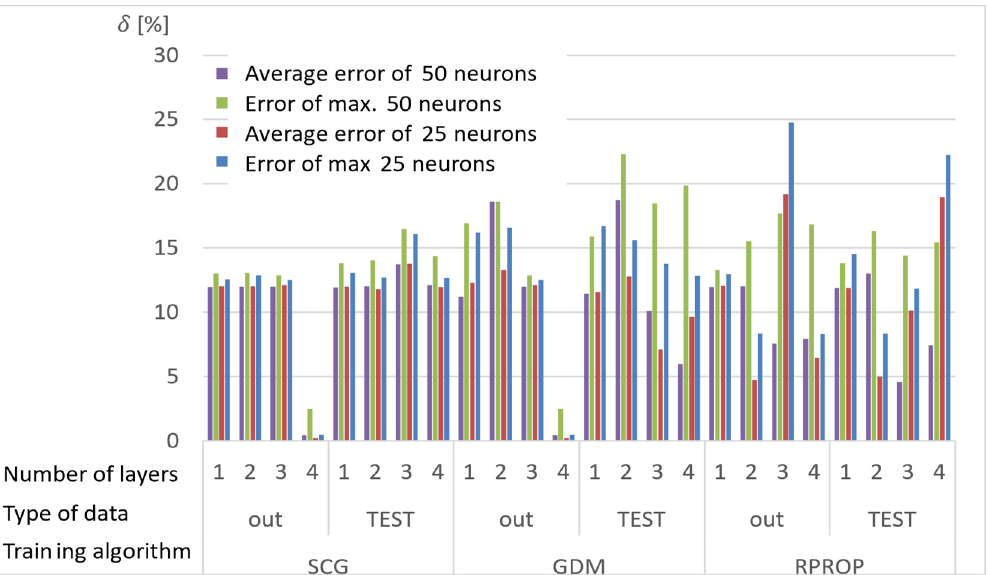
Figure 9. Maximum and average relative error for selected structures of neural networks and training algorithms after the third training cycle.